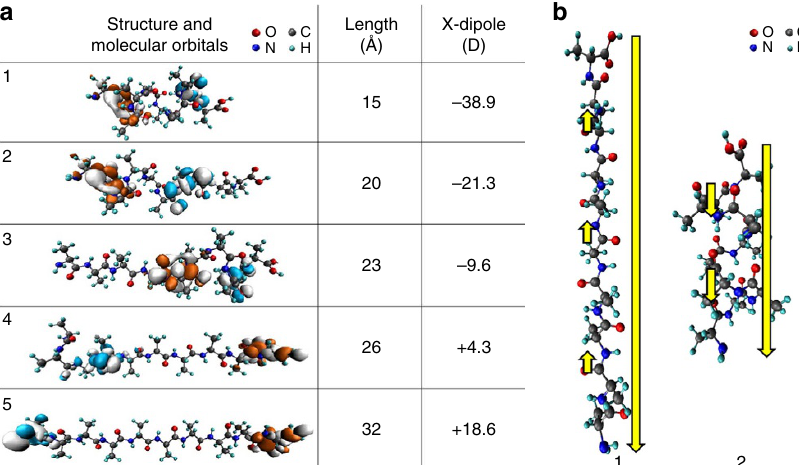
Figure 3 | Calculated structures and dipole moments of oligoalanine molecules. ( a ) Several structures of 10-mer oligoalanine molecules, gradually stretched from their a -helix conformation to a linear one. For each structure, the molecular length (determined by the distance along the molecular axis between the two farthest C atoms), as well as the DFT-computed dipole moment along the molecular axis and the highest occupied (light blue) and lowest unoccupied (orange) molecular orbitals, are given. ( b ) The change in dipole direction upon structural conformation of 10-mer oligoalanines, demonstrated schematically for the most linear and most helical conformations of the examined peptides. Long arrows indicate the dipole formed between the C-terminus and the N-terminus of the peptide. Short arrows indicate local dipoles formed by peptide bonds.